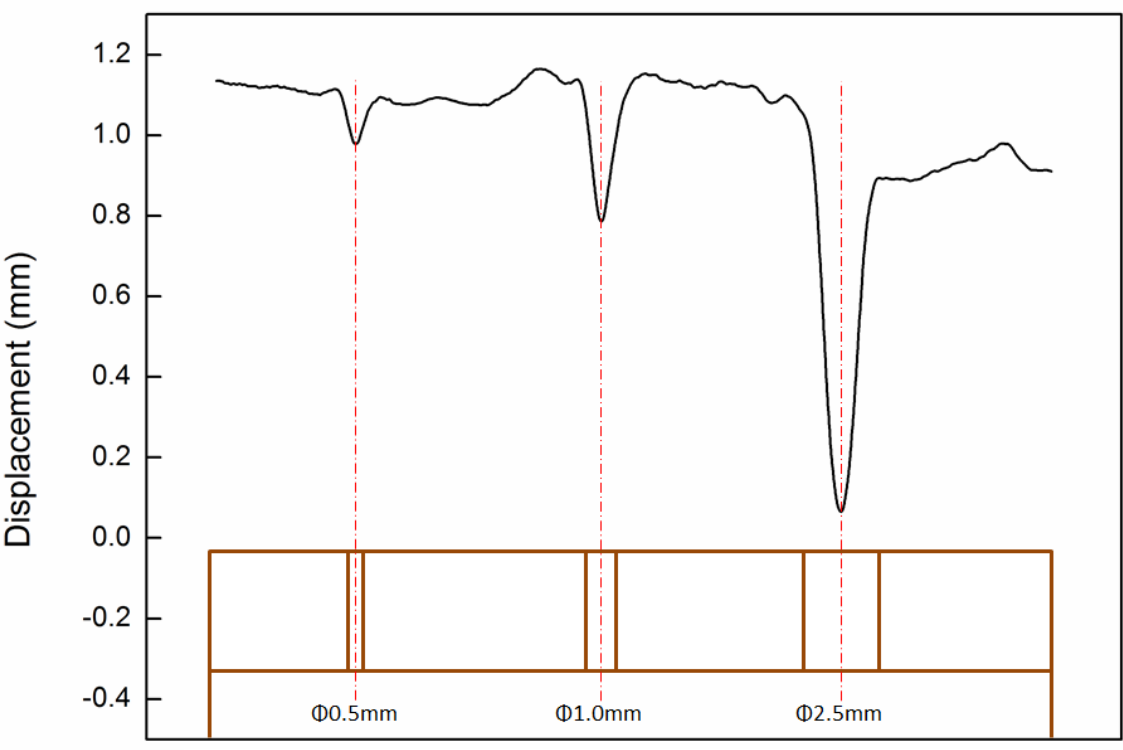
Figure 4. Output signals corresponding to hole defects with different sizes.